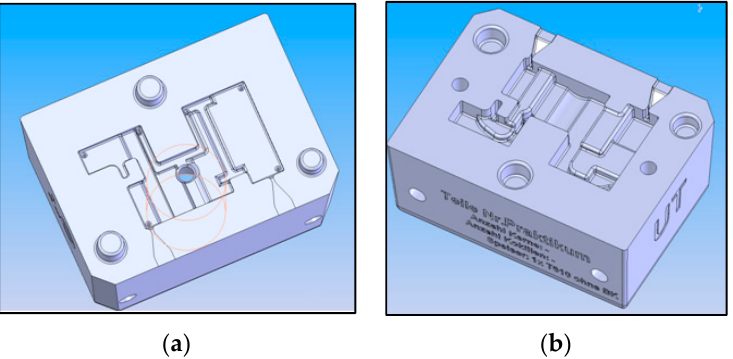
Figure 2. Ceramic molds for the hydraulic block of the railway installation: ( a ) Upper mold/die; ( b ) Lower mold/die.